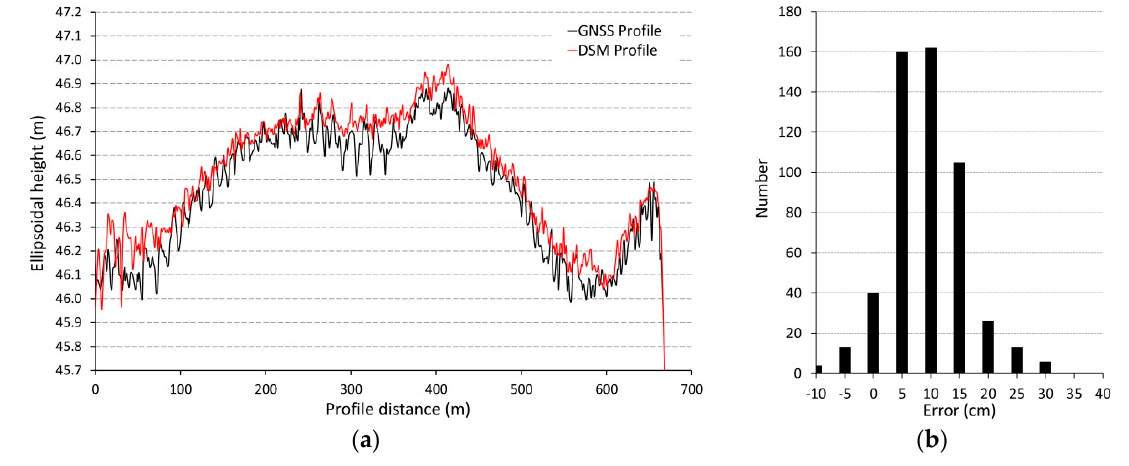
Figure 9. ( a ) Ellipsoidal heights of the GNSS profile (in black) and extracted from the DSM (in red) of campaign 2 and ( b ) histogram of the ellipsoidal height differences.